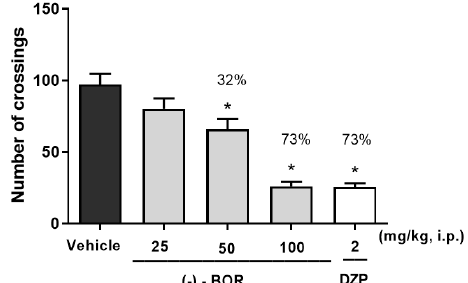
Figure 3. The effect of (–)-BOR (25, 50, and 100 mg/kg, i.p.) and DZP (2 mg/kg, i.p.) on the open field test with mice ( n = 6). Each bar represents the mean ± S.E.M. of the number of quadrants crossed by the animals. * p < 0.05 is significant compared to the vehicle group (ANOVA and Student-Newman- Keuls test as the post hoc test).